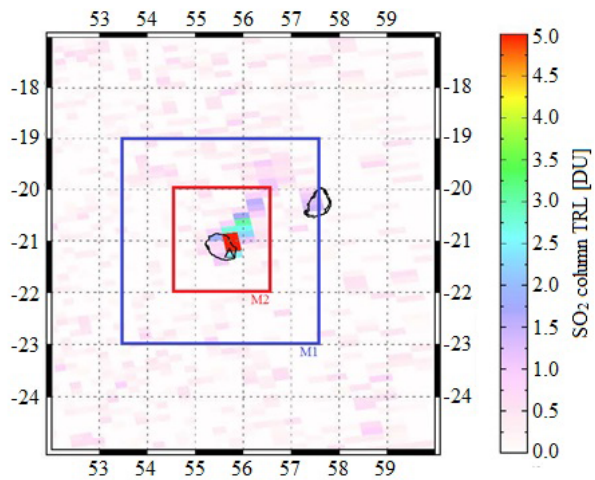
Table 1. Characteristics of the methods incorporated in the development of an automatic classification technique. Method Sample area size Position Correction technique M 1 4 ◦ × 4 ◦ Centred over the volcano None applied M 2 2 ◦ × 2 ◦ Centred over the volcano None applied M 3 2 ◦ × 2 ◦ Centred over the volcano Assumes that the plume is predominantly confined to the M 2 region and utilises the M 1 region to define the background SO 2 level (Eq. 1)